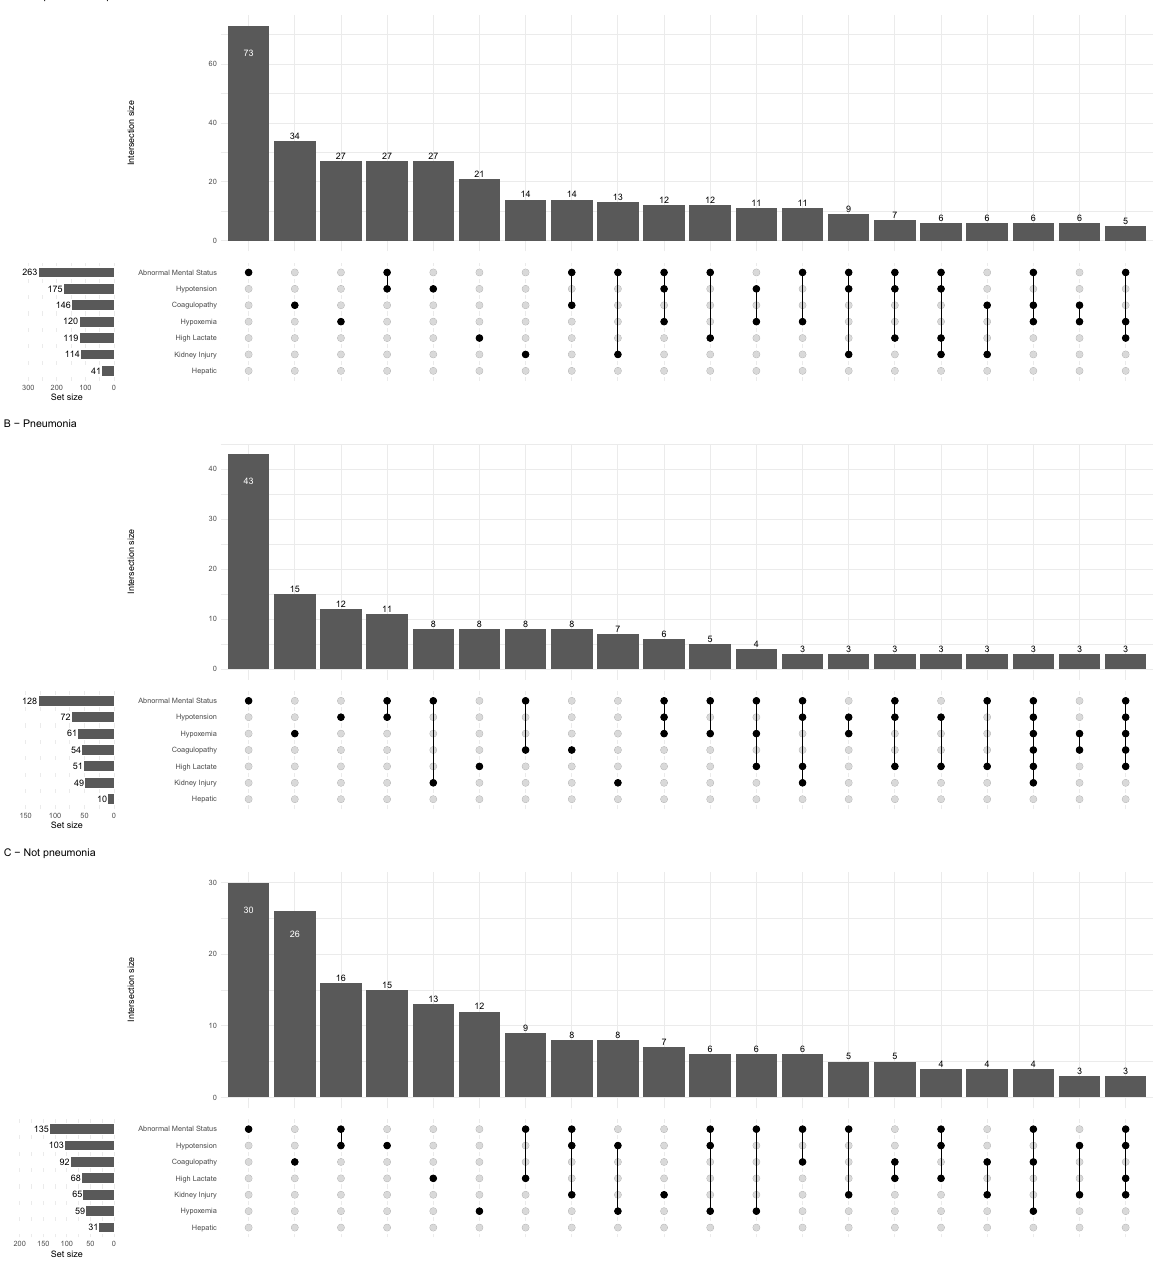
Fig. 1 Organ failure at diagnosis in A all septic patients, B pneumonia, C not pneumonia. Each dot represents intersections, with the number of cases shown in